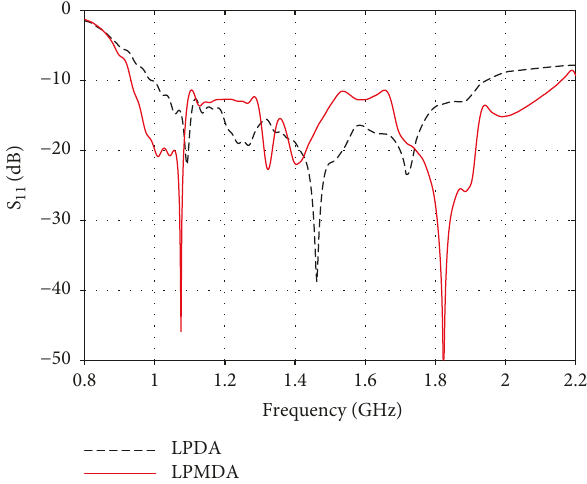
Figure 3: Simulated re fl ection coe ffi cients of a typical log-periodic dipole array (LPDA) antenna and of the LPMDA